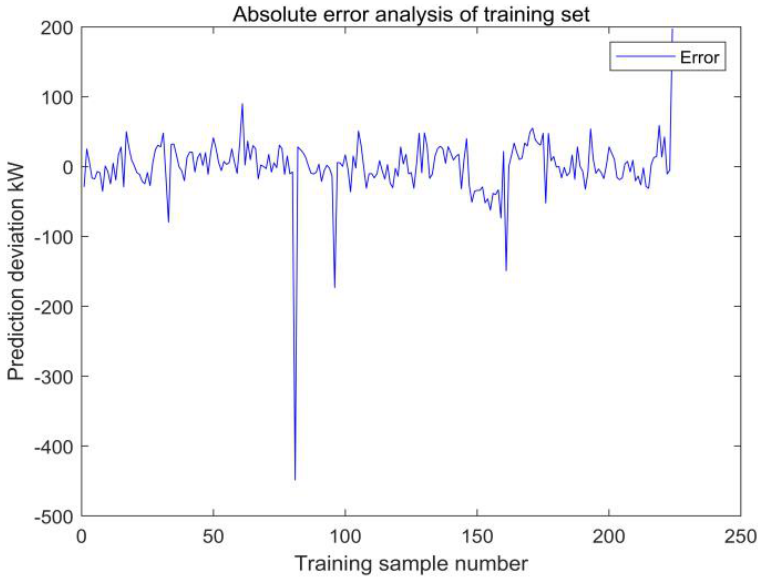
Figure 19. Absolute error plot of training set. As shown in Figure 20, the relative errors of most of the data are guaranteed to be within 10%, and only very few data points have relative errors of more than 50%. trained and has a good